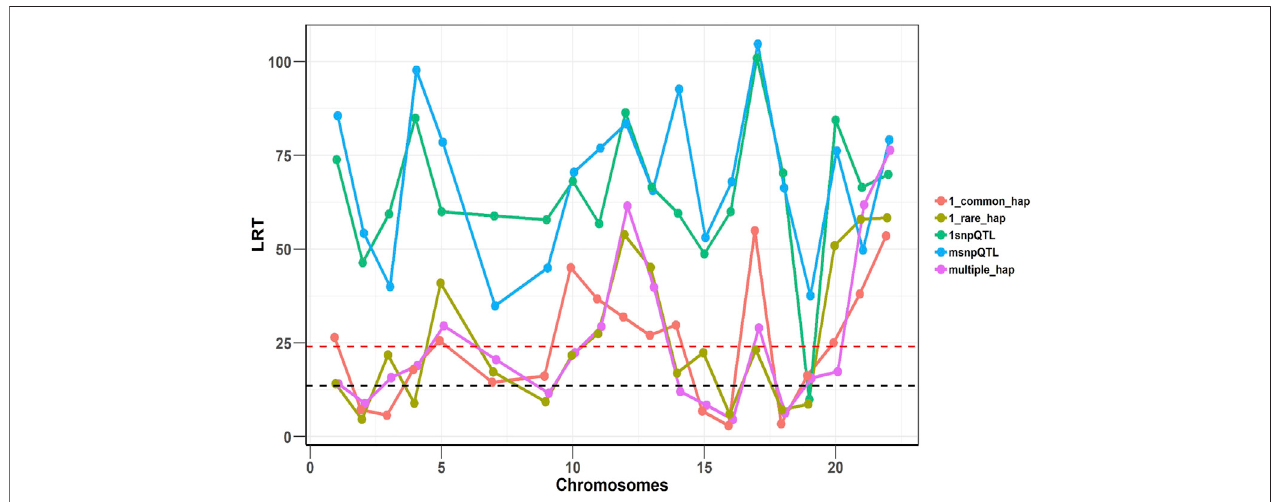
FIGURE 4 | Joint analysis of the SNP and haplotype phenotypes using SNHap-RHM. The plot is an analysis of one replicate of each of the simulated phenotypes. The LRT statistics are plotted over QTL loci across the chromosomes. The red dashed lines are genome-wide signi fi cance threshold (for 48,772 regions) and the black dashed lines are Bonferroni signi fi cance threshold (for 220